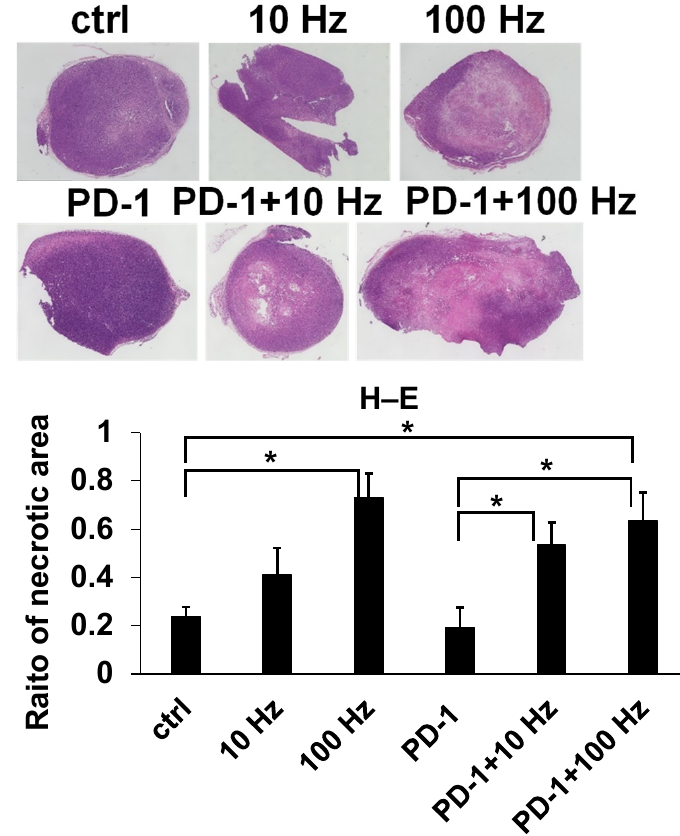
Figure 6. H–E stain analysis of TRAMP-C2 mice tumors. After US irradiation treatment and US + ICIs combination treatment in TRAMP-C2 mice, H–E staining was performed on the removed tumors. In the H–E staining analysis, the area of necrosis was measured with respect to the area of the entire tumor. The necrotic area is a pale pink (*: p < 0.05).